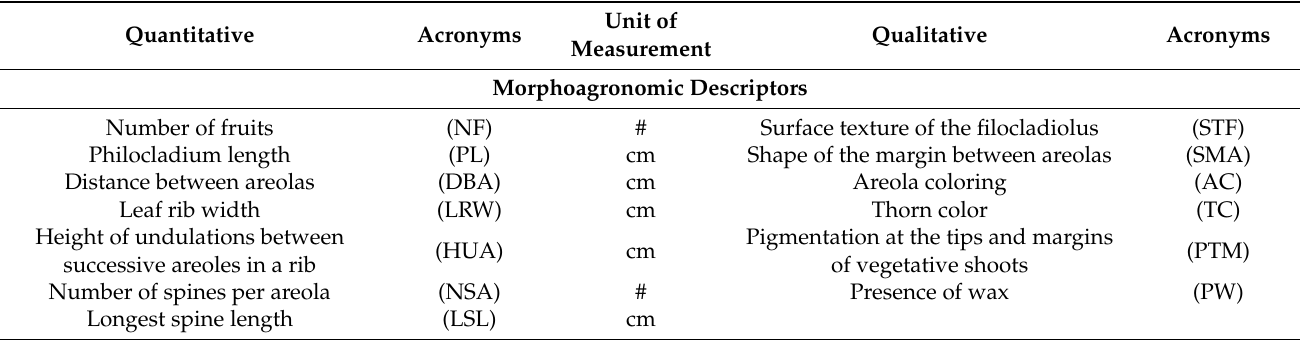
Table 4. Morphoagronomic descriptors used for the characterization of yellow pitahaya materials and morphoagronomic and physicochemical descriptors of the fruits of the yellow pitahaya materials.